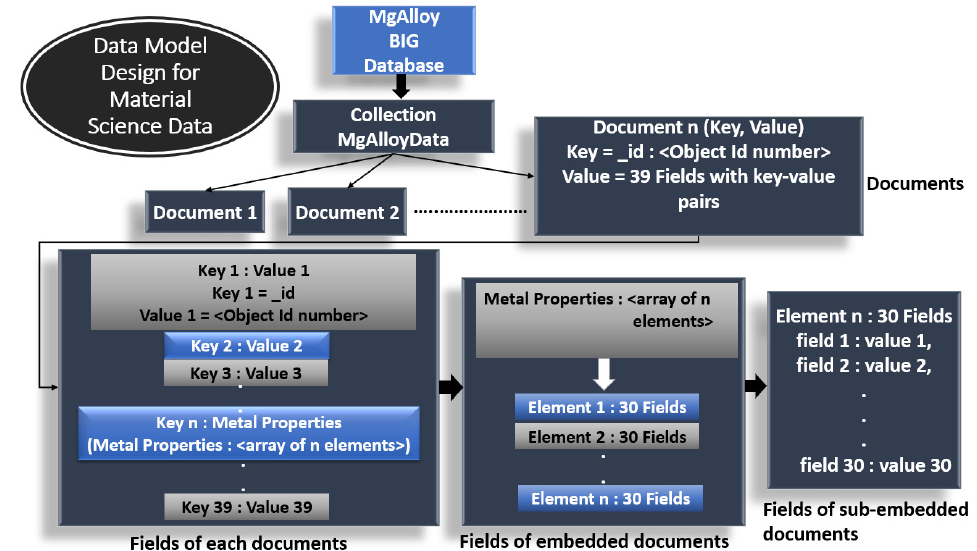
Figure 2. Data Model Design for Material Science data.